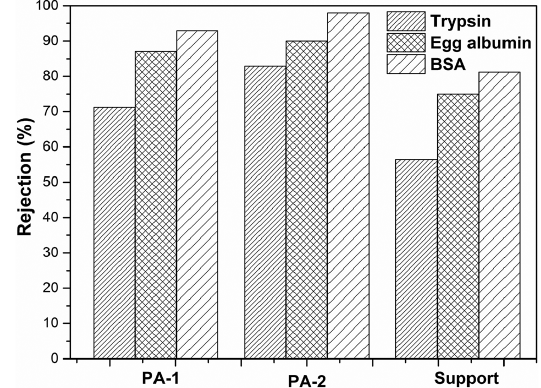
Figure 7. The influence of polymer deposition in protein rejection.